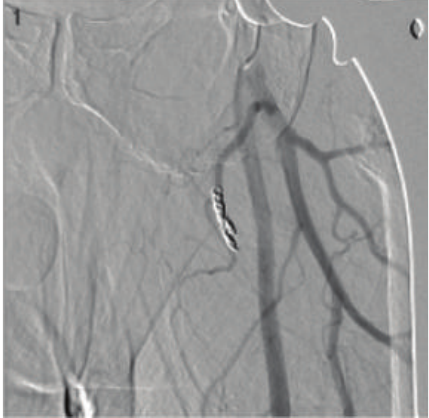
Figure 9: Angiogram showing coil in profunda femoris artery with elimination of the pseudoaneurysm previously